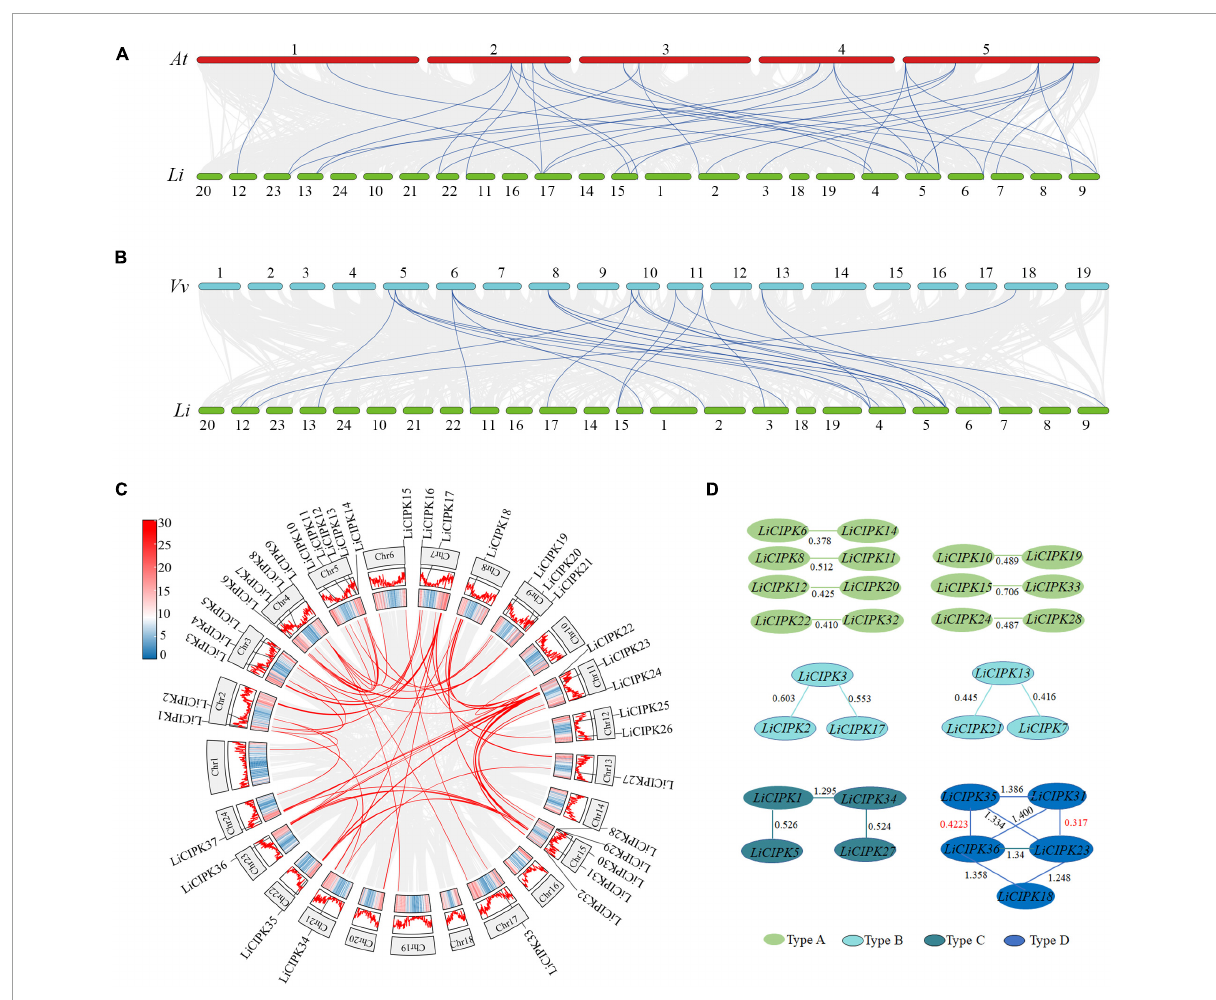
FIGURE4 Inter- and intraspecies collinearity of CIPK loci. (A) AtCIPKs vs. LiCIPKs . (B) VvCIPKs vs. LiCIPKs. The light gray lines indicate the synteny between species, blue lines indicate cognate loci of CIPKs. (C) LiCIPKs vs. LiCIPKs . Red lines show synteny loci of LiCIPKs . Gene density across chromosomes are indicated by hot map (inner circle) and column map (medium circles), out circle show length of chromosomes. (D) Classification of duplicated LiCIPK . Light green, cyan, dark green, and blue indicate duplicated LiCIPKs containing two, three, four, and five members, respectively.